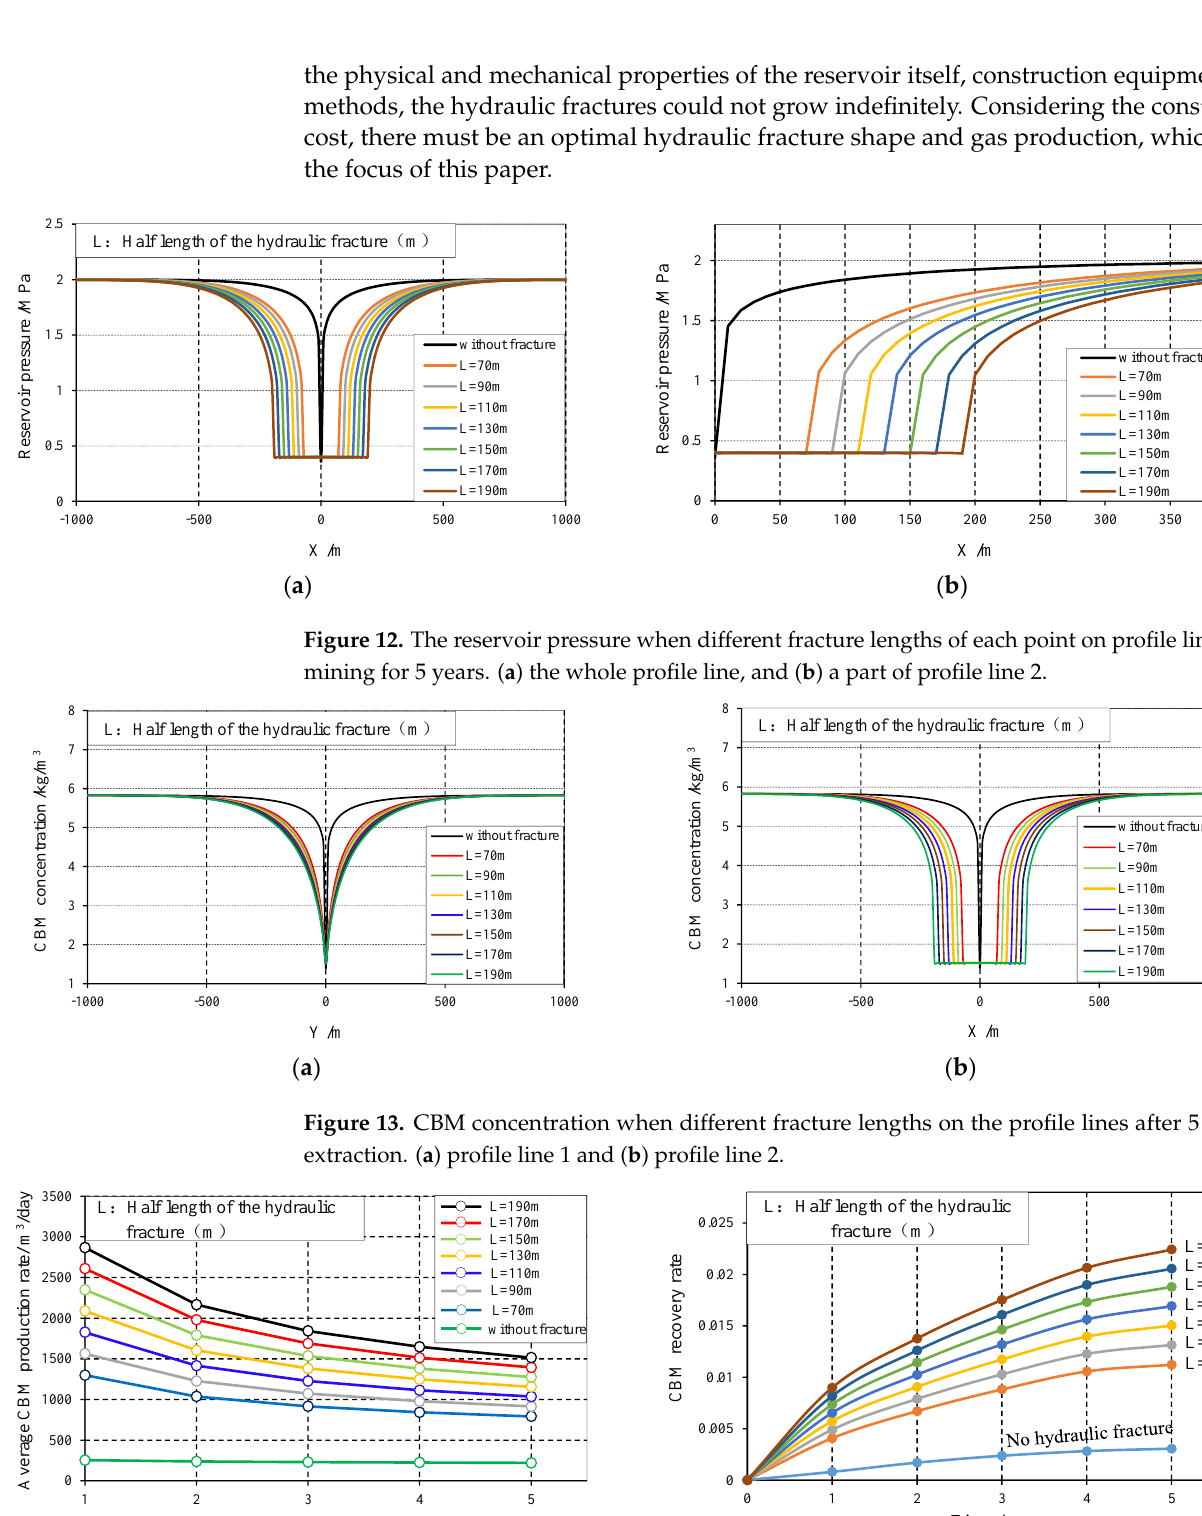
Figure 11. The reservoir pressure when different fracture lengths of each point on the profile line 1 after mining for 5 years. ( a ) the whole profile line, and ( b ) a part of profile line 1.